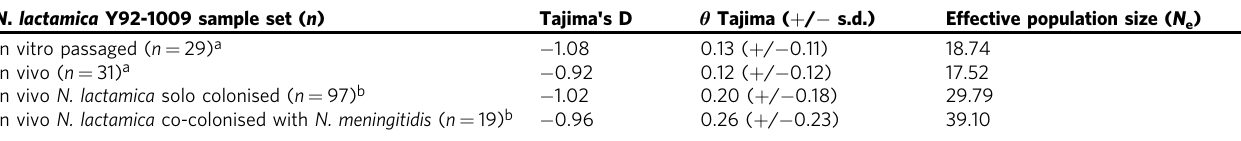
Table 2 Effective population size and Tajima ’ s D calculated for N. lactamica Y92 – 1009 sample sets N . lactamica Y92-1009 sample set ( n